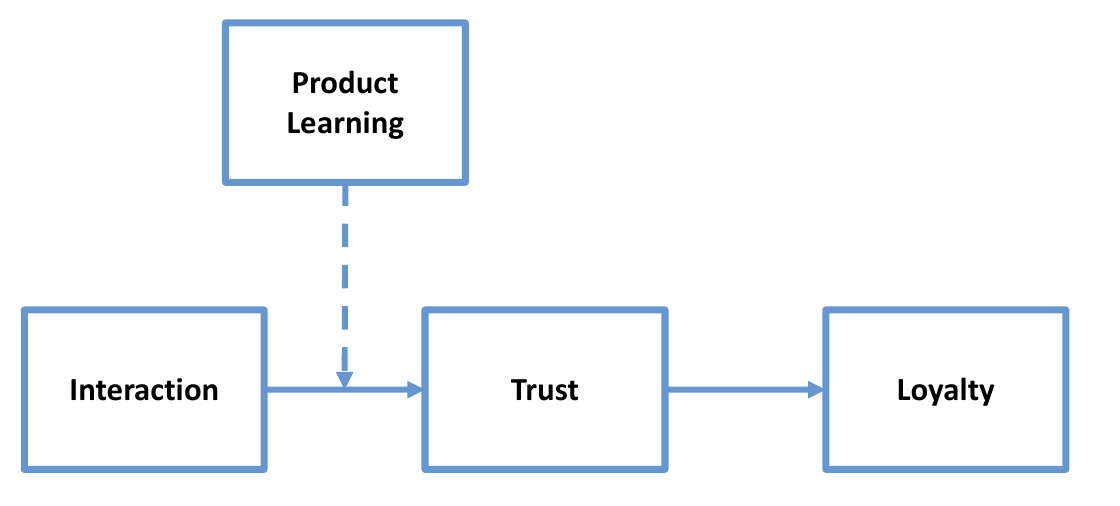
Fig. 1. Theoretical model of the